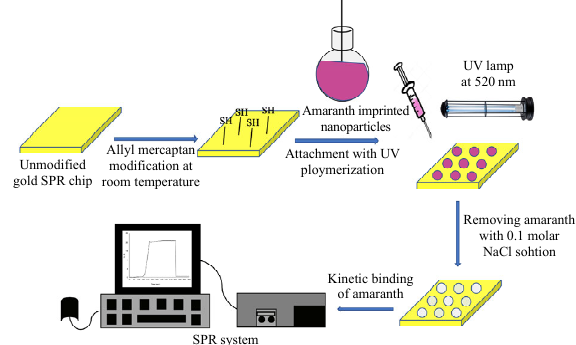
Fig. 2 Step-by-step schematic representation of SPR sensor surface preparation and SPR